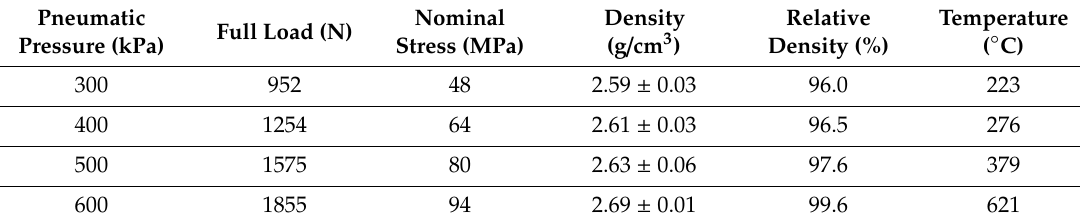
Figure 3. ( a ) Load–time curves during UAS process of aluminum particles. ( b ) Shrinkage curve during UAS process. Table 1. Full load, nominal stress, density and temperature of the ultrasonic assisted sintering process.